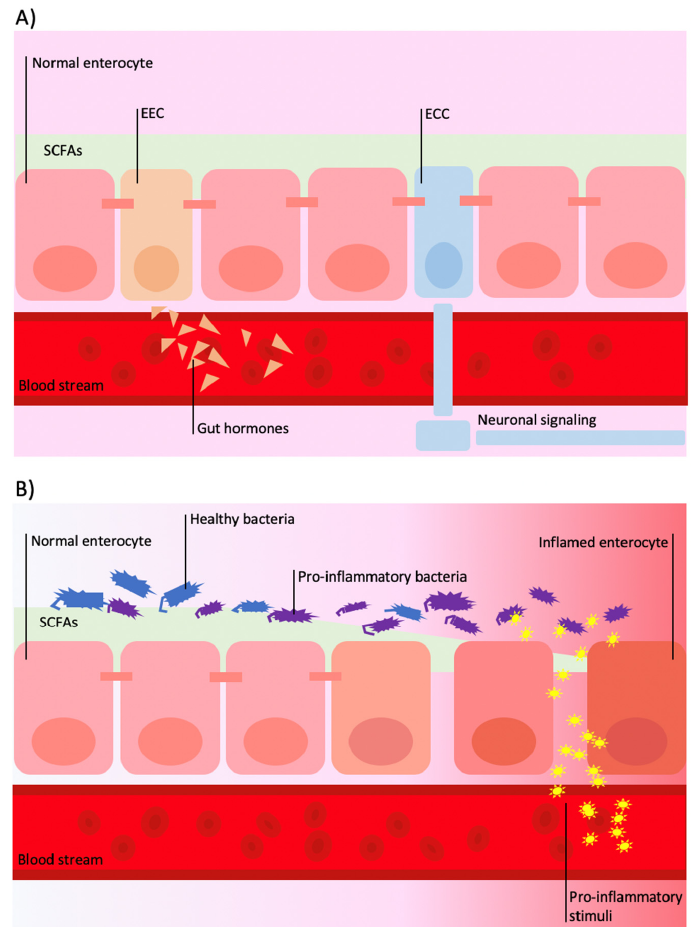
Figure 2. Schematic illustration of gut–brain communication through systemic involvement. ( A ) In physiologic conditions, the gut is able to transmit signals at systemic level by activation of enteroendocrine cells (EECs) and enterochromaffins cells (ECCs): EECs are responsible for secretion of various circulating hormones (i.e., glucagon-like peptides (GLPs), peptide tyrosine tyrosine (PYY), oxyntomodulin); ECCs are responsible for direct neuronal signaling through vagal or afferent nerve fibers by controlling serotonin release. ( B ) Modification of gut microbiota, such as a decrease in commensal Bifidobacterium and Lactobacillus strains and increase in Bacteroides / Prevotella species, may lead to a reduction of short-chain fatty acids (SCFAs) including acetate, propionate, and butyrate and hyper-secretion of lipopolysaccharides (LPS) that bind to circulating monocyte and macrophages, which, in turn, stimulate the secretion of pro-cytokines (TNF-a, IL-1,